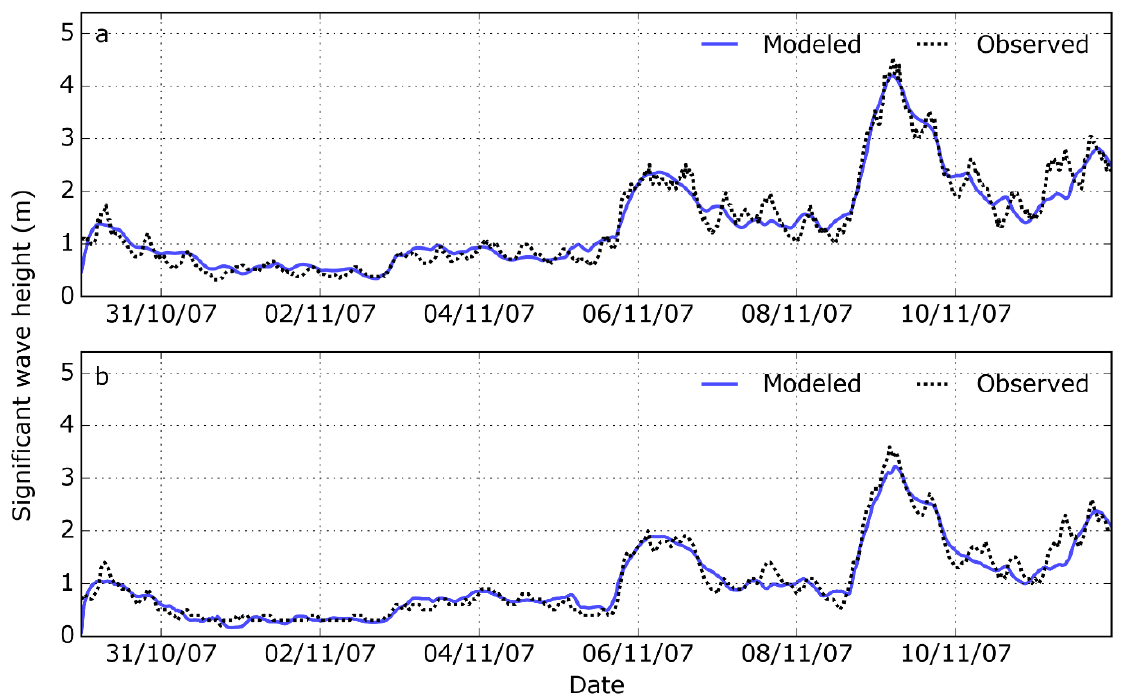
Figure 5. Comparison of modeled and observed significant wave heights for the period 30 October 2007 00:00:00 to 11 November 2007 00:00:00: ( a ) Blakeney Overfalls; ( b ) Cley. RMSE = 0.21 m at Blakeney Overfalls and 0.18 m at Cley. For locations, see Figure